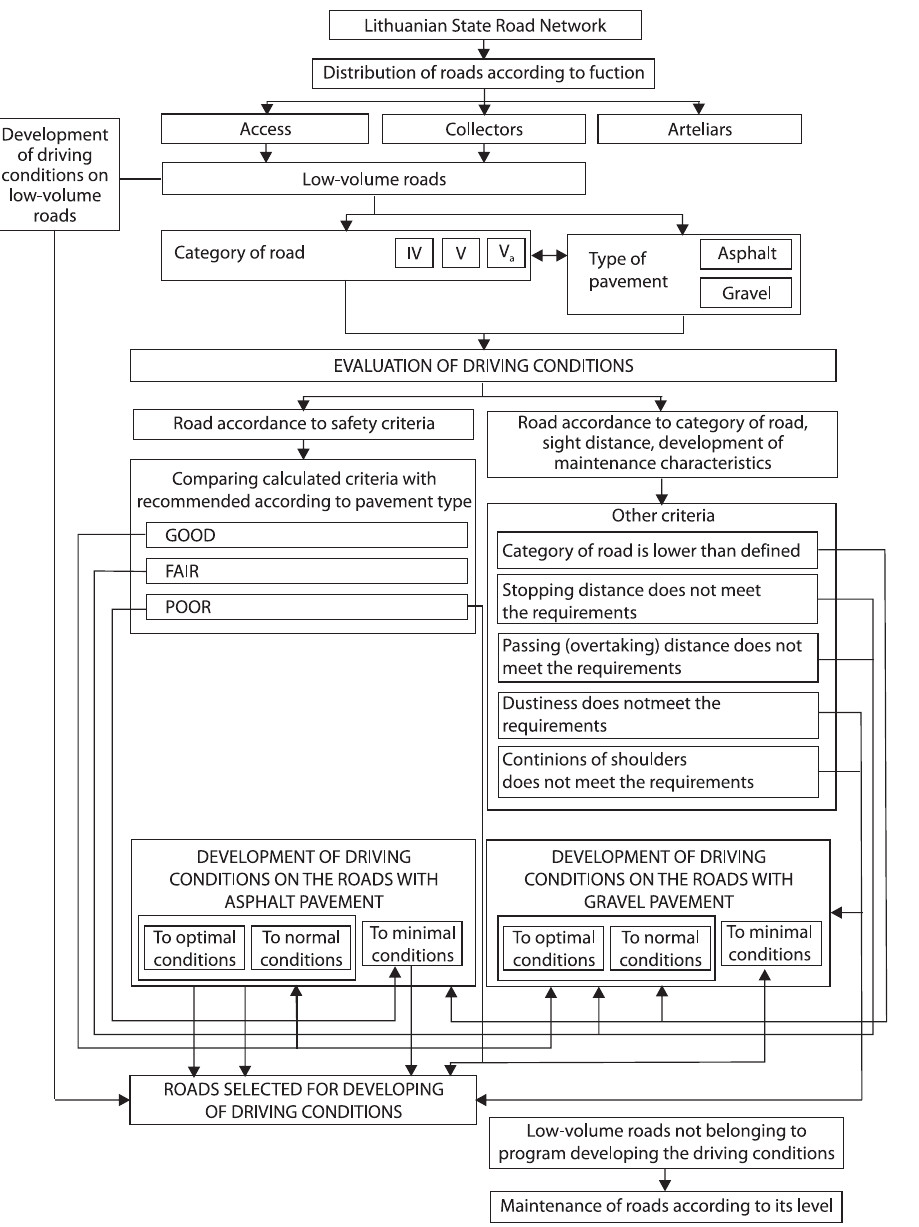
Fig. 4. Model for the improvement of driving conditions on the operating